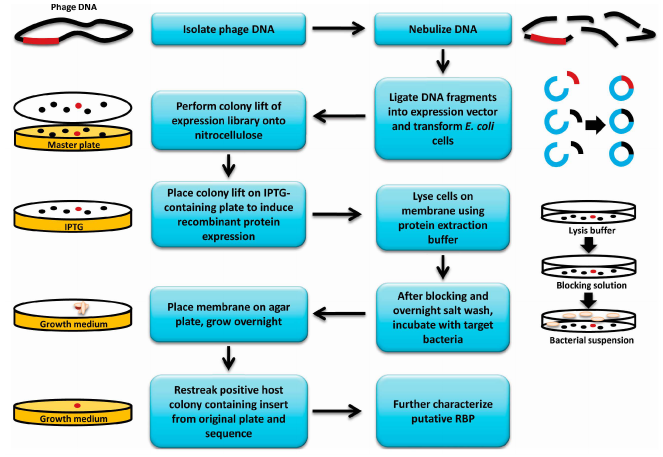
Figure 1. Overview of receptor binding protein (RBP) discovery assay. A flowchart and graphical representation summarizing the methodology used to discover new phage receptor binding proteins. Red dots represent an E. coli colony expressing an RBP gene among a library of colonies expressing other fragments of the genome (black dots). Red gene fragments represent an RBP gene, while black gene fragments represent other fragments of the genome. Blue fragments represent vector DNA, and beige ovals represent bacterial cells incubated with the colony lift